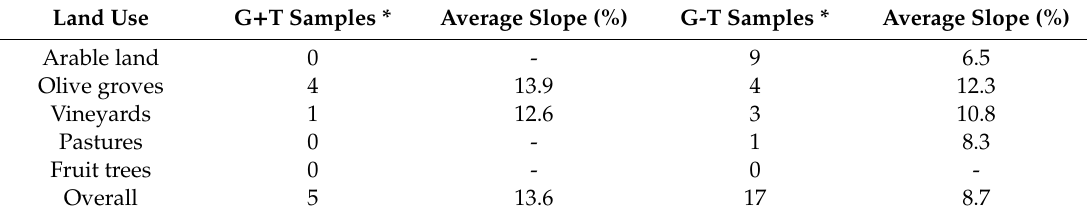
Table 2. A summary of the relation of gullies with terraces per land use in